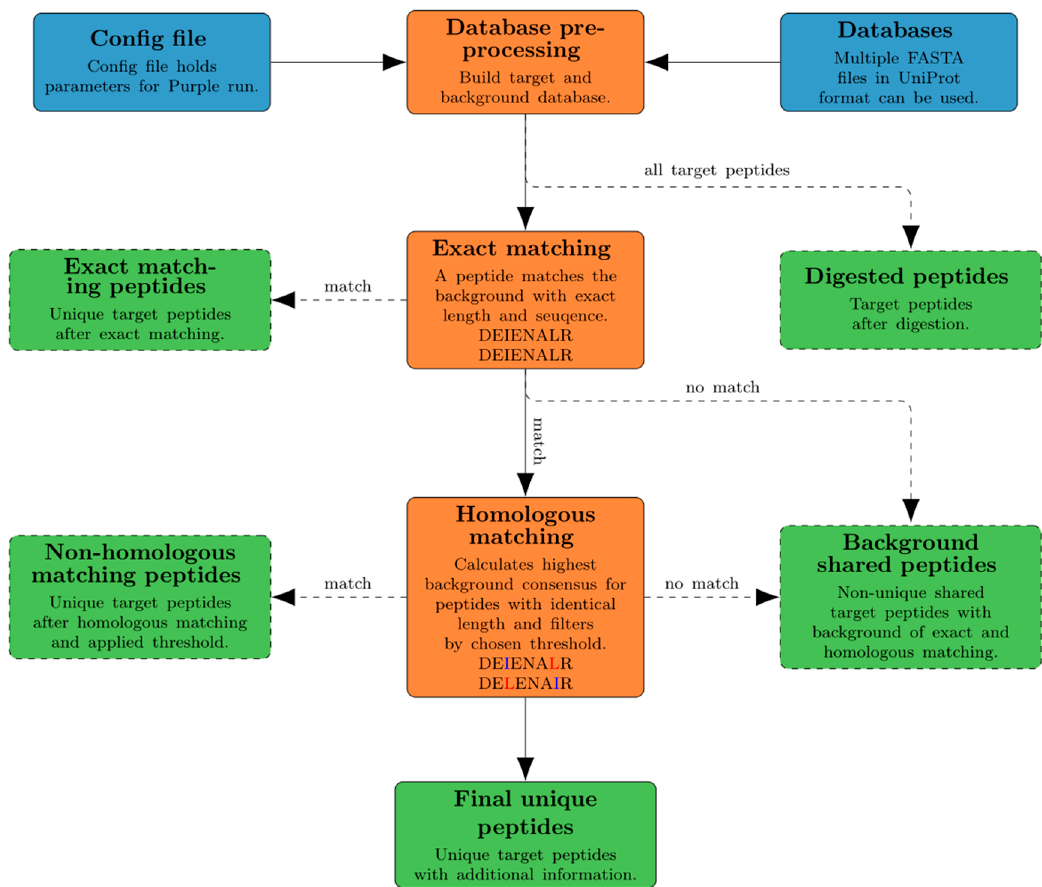
Figure 1. Overview of the Purple workflow. A configuration file and a directory path to the location of FASTA databases serve as input (blue). In the database preprocessing step, the databases are separated into target and background (orange). Any target peptides exactly matching to the background database are removed. In the homologous matching step, any target peptides that have similar sequences are filtered out (orange). All intermediate and final results are exported automatically to a user-defined output folder (green).